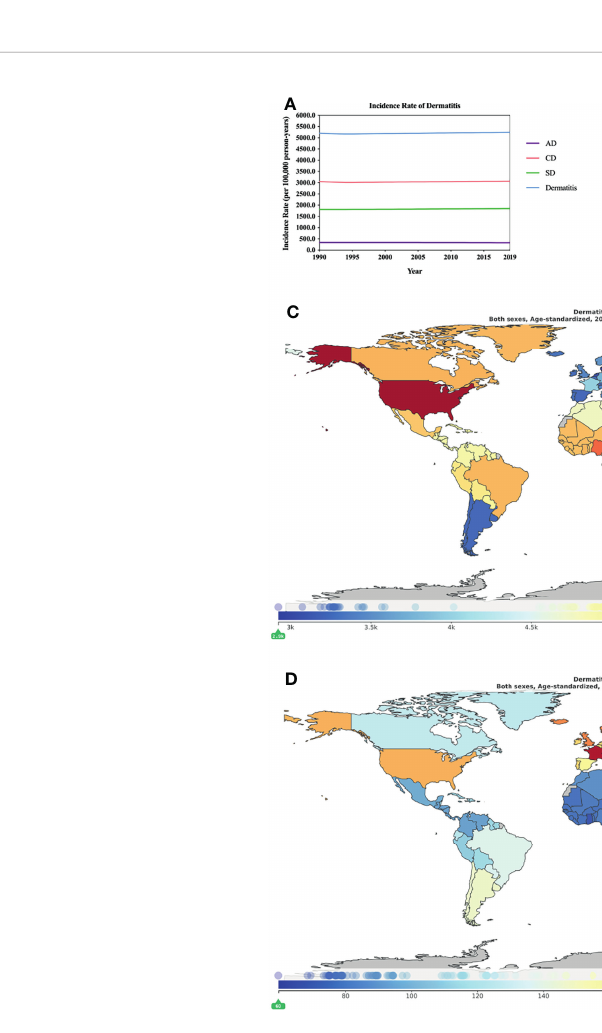
FIGURE 1 | Burden of dermatitis for 204 countries and territories. ASIR (A) and ASDR (B) per 100,000 people (1990 – 2019) with dermatitis by country and region. The distribution of ASIR (C) and ASDR (D) per 100,000 population with dermatitis globally in 2019. (C, D) were generated by